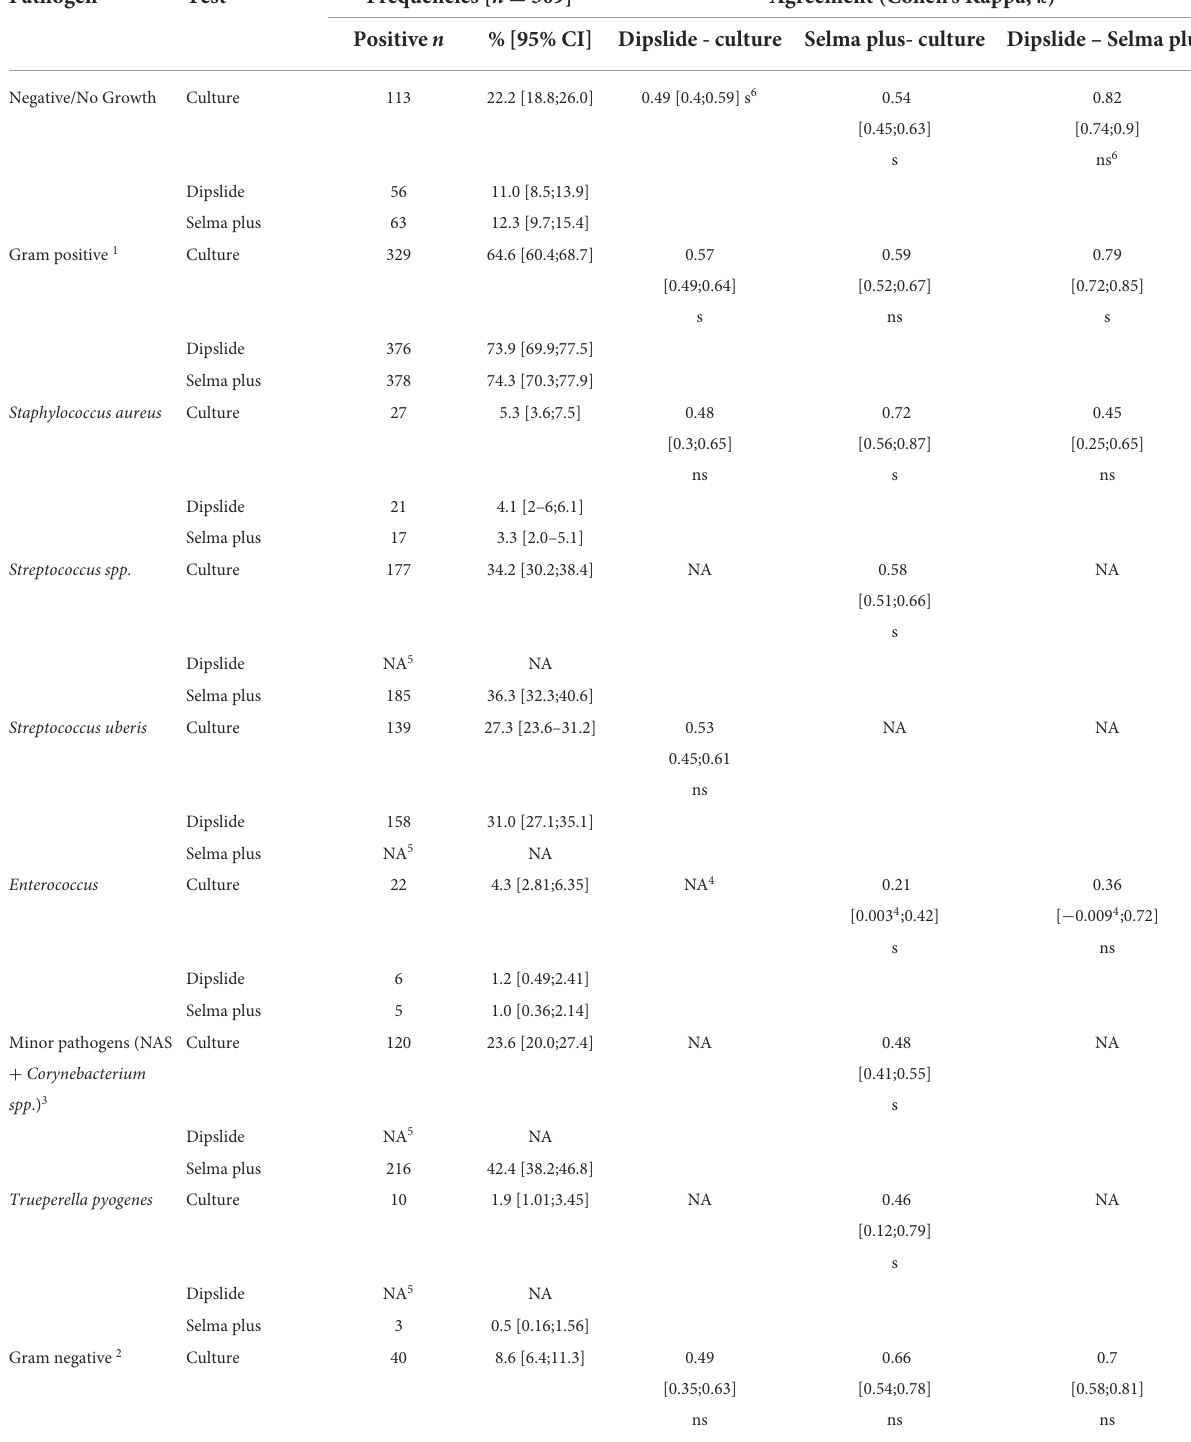
TABLE 1 Descriptive statistics and Cohen’s kappa agreement for 509 single quarter milk samples collected from 509 Swiss dairy cows suffering from clinical and subclinical mastitis.